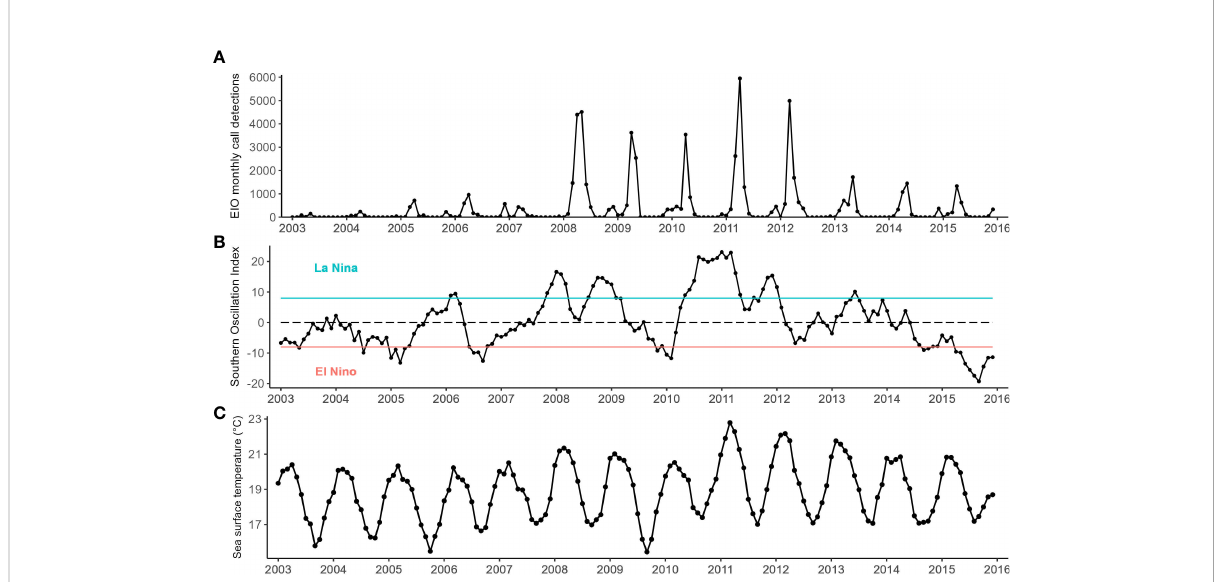
FIGURE 3 Monthly time series of (A) eastern Indian Ocean (EIO) pygmy blue whale call detections between 2003 and 2016 at Cape Leeuwin, Western Australia, (B) Southern oscillation index (SOI) obtained from the Australian Bureau of Meteorology calculated as a three-month running average between 2003 and 2016 SOI values above the green line indicate La Niña conditions; SOI values below the red line indicate El Niño conditions, (C) mean sea surface temperature measured across a 1° x 1° latitude and longitude grid centred around the Cape Leeuwin hydrophone.